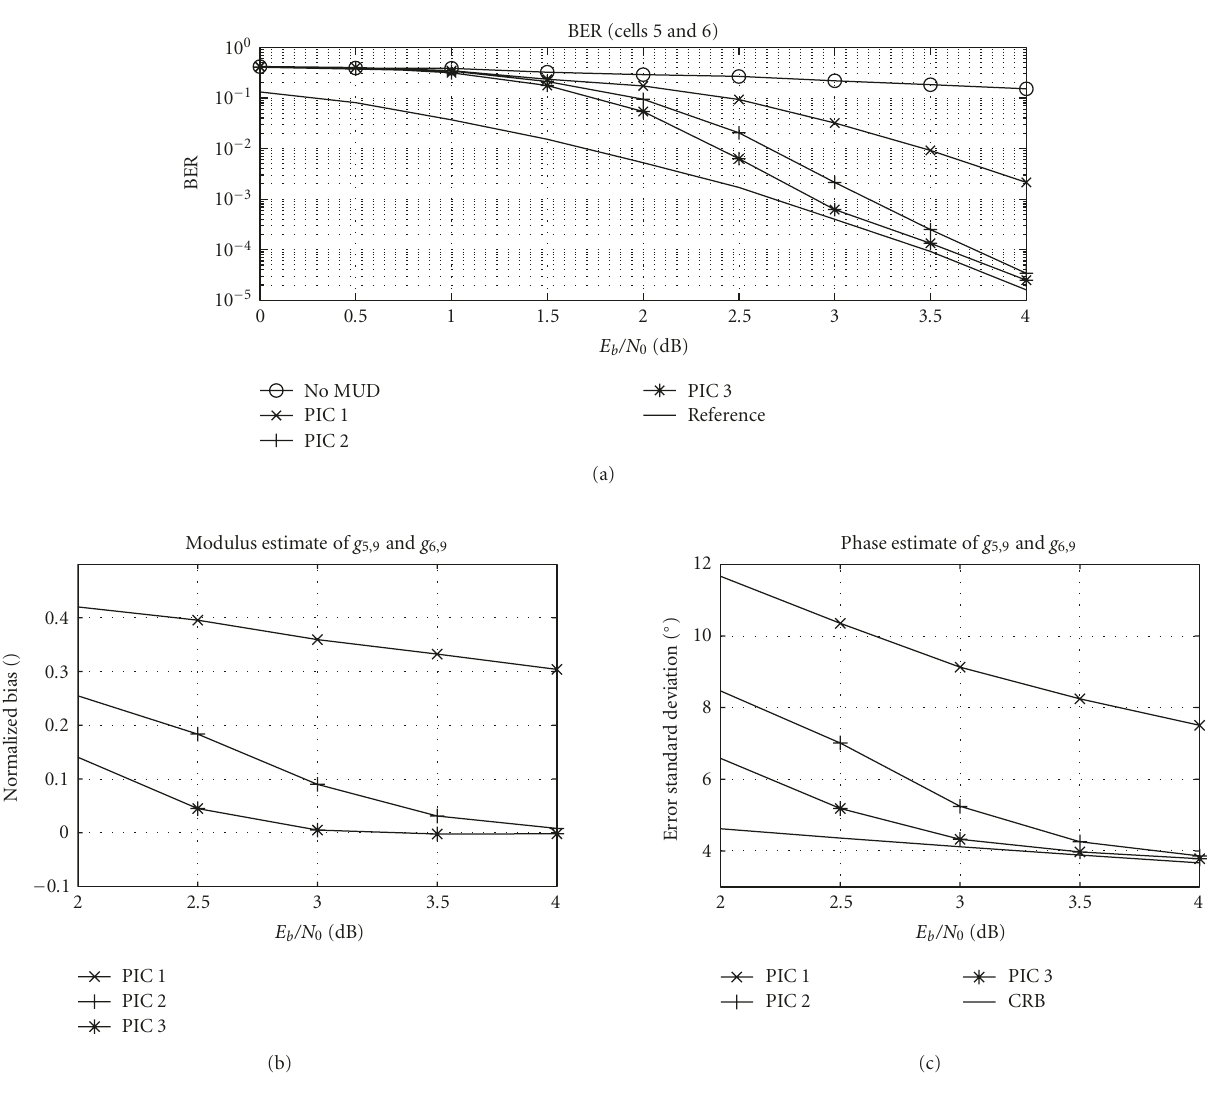
Figure 4: Results with time-invariant